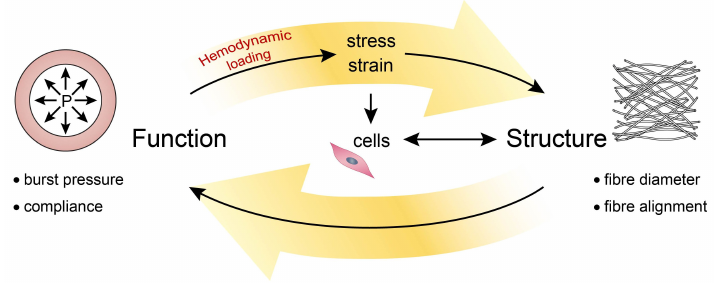
Figure 2. Interrelationships between structure and function: functionality (in terms of mechanical properties) follows directly from structure, which is regulated by cell-mediated growth and remodeling in response to mechanical loading (in terms of stress and